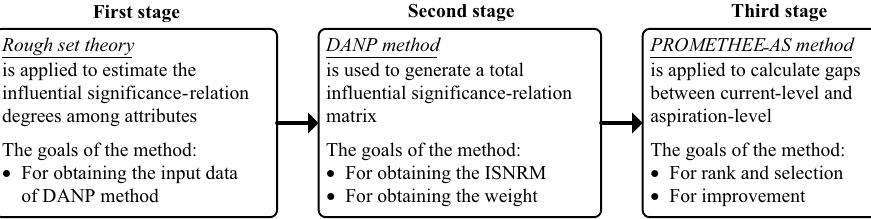
Figure 1. The modelling process of the integrated data-driven MADM